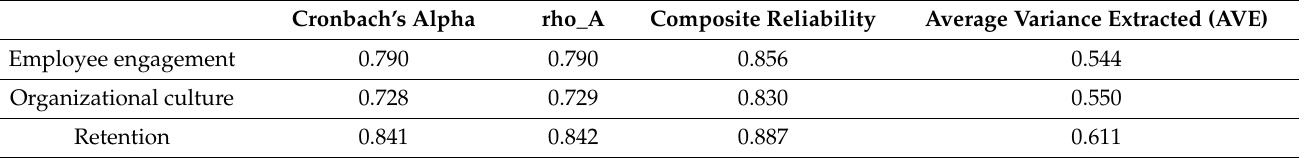
Table 2. Reliability and convergent